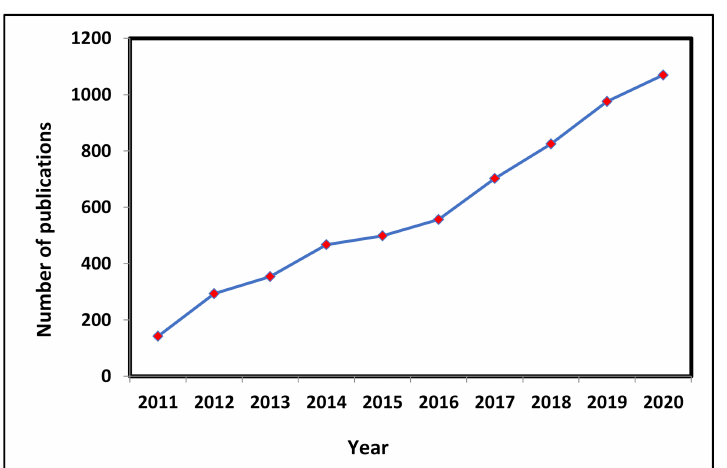
Figure 20. Research publications on nanotechnology-enabled sensors during the last